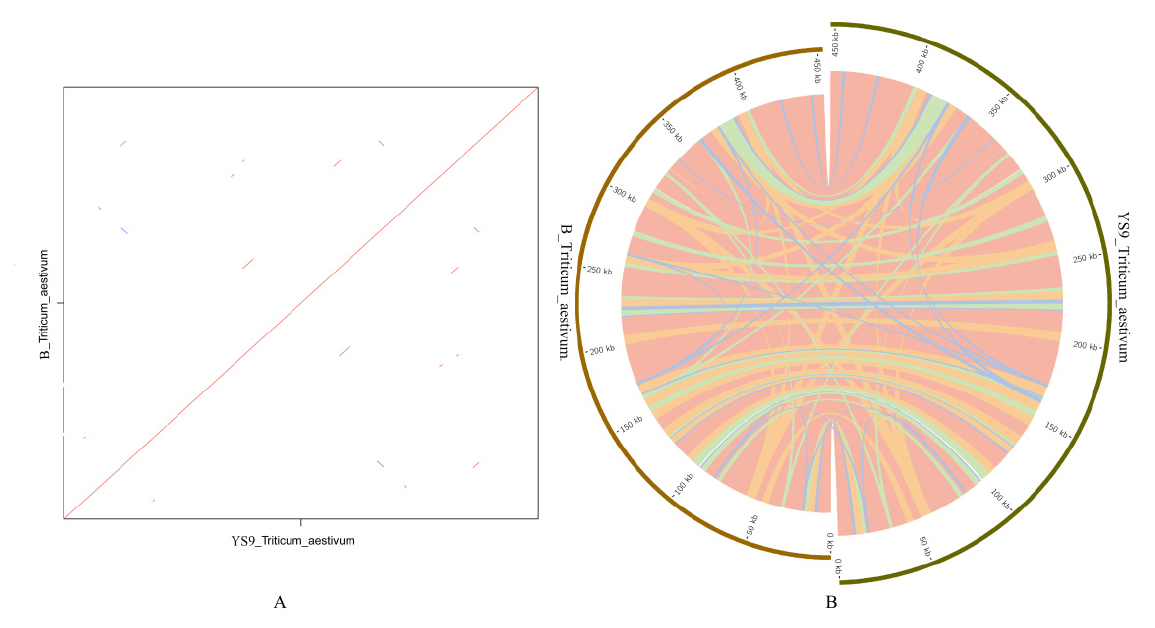
Figure 7. A similarity comparison of the two respective mitogenomes in the B (the B-type CMS line) and YS9 (its maintainer line) wheat. ( A ) Result for the comparison using BLAST+; ( B ) comparison results were imported into Circos software to draw the circos diagram, whose colors represent different comparison lengths of the sequences: red, quartile to max value; orange, median to upper quartile; green, lower quartile to median; blue, min to lower quartile.